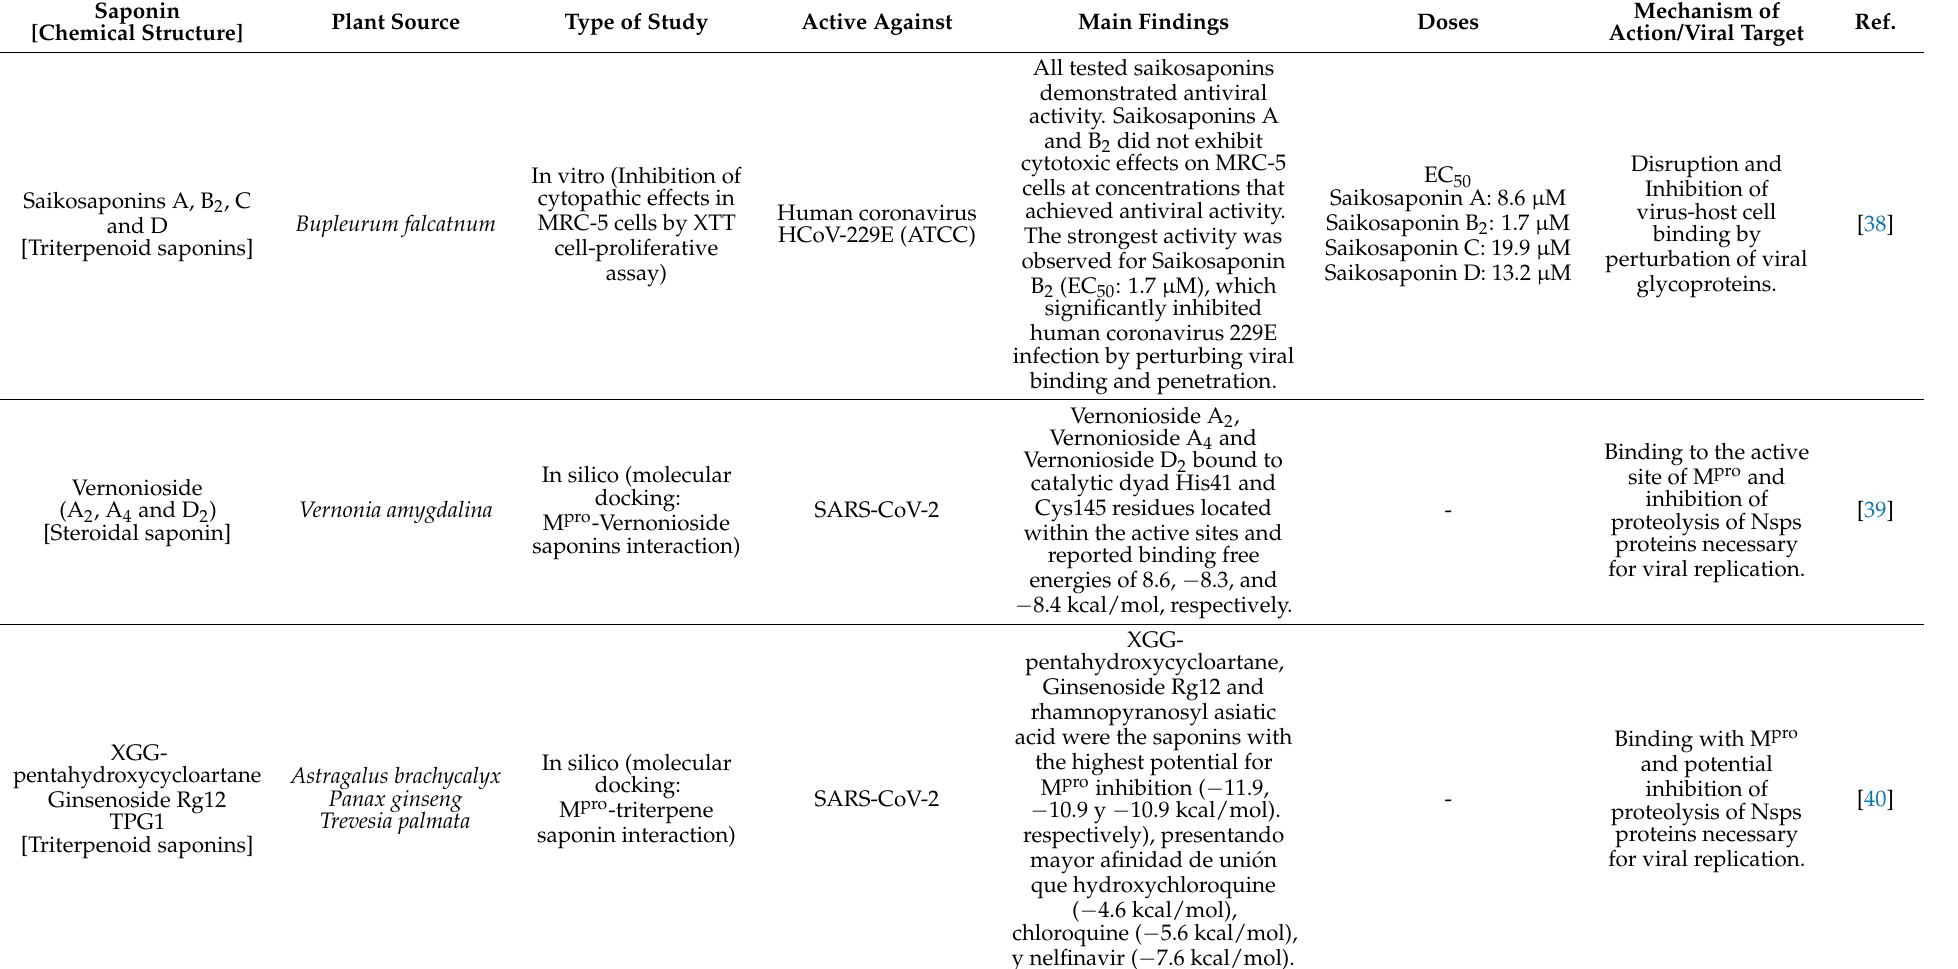
Table 1. Summary of the main studies related to the anti-SARS-CoV-2 activity of saponins and their effects on possible pharmacological